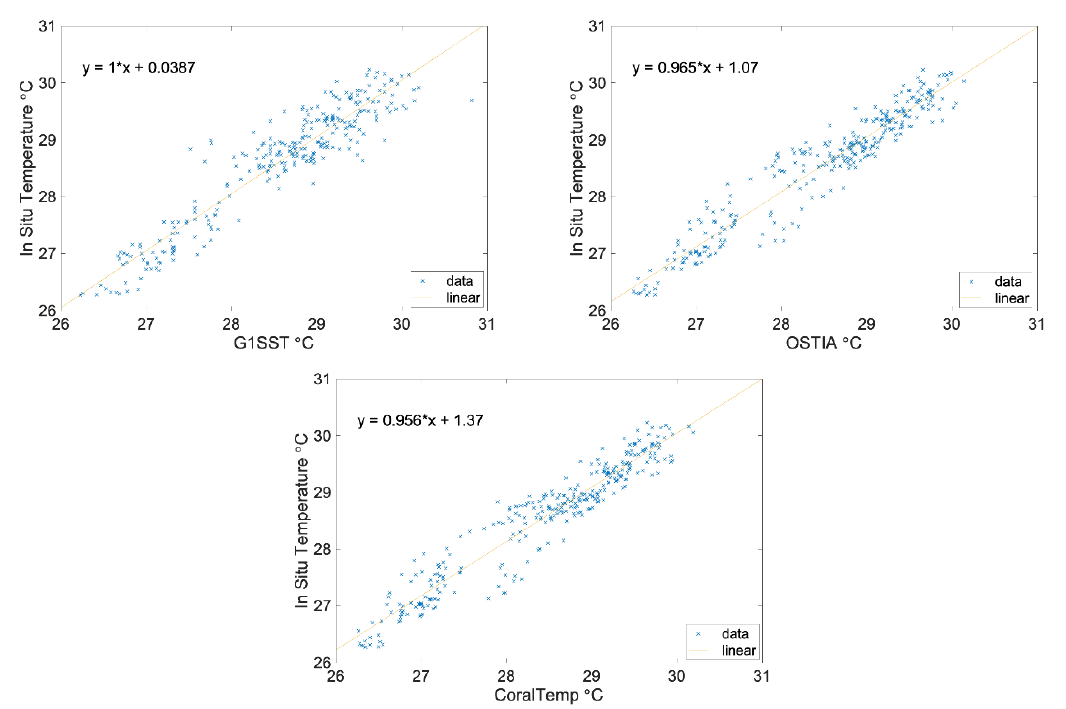
Figure 9. Scatter plots with linear regression of the averaged in situ temperature against the different three different remote sensing SST datasets for San Cristobal.